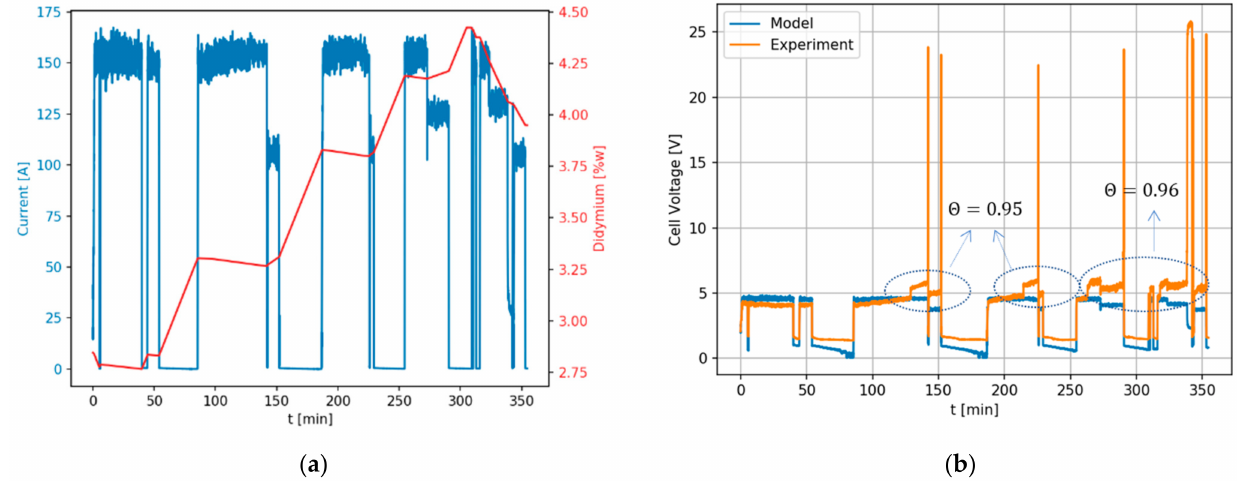
Figure 6. ( a ) Applied current and estimated oxide content; ( b ) measured cell voltage compared to the model for unstable